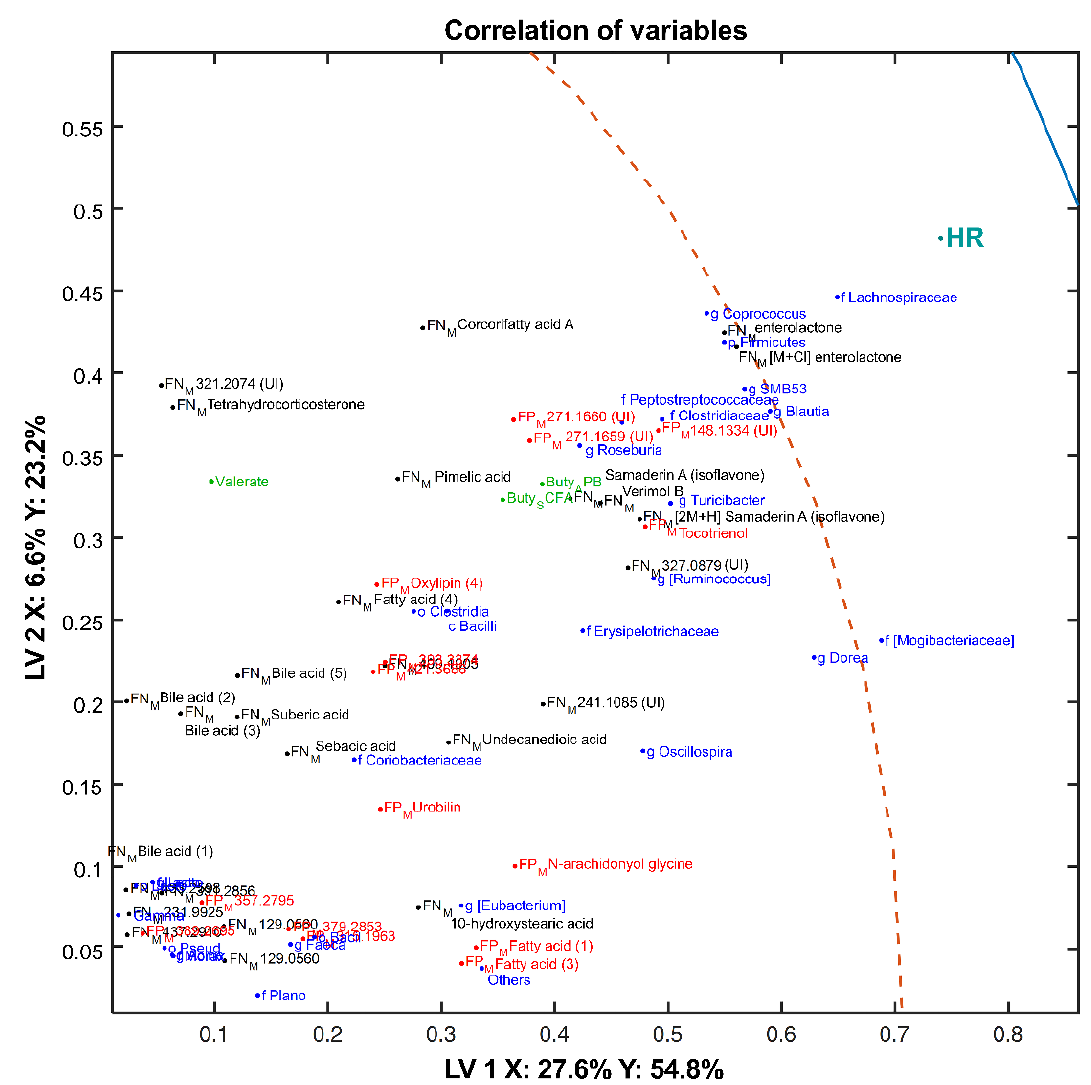
Figure 10. A detailed view of the correlation loading plot focusing on variables strongly associated with the HR diet (for a global overview of the correlation plot, we refer to Figure S5). Scores of a 4-block model: fecal ESI + metabolomics (FP M , red), fecal ESI − metabolomics (FN M , black), SCFAs (green), metataxonomics (blue) are used to plot the correlations. The first two components are shown with the explained variances in sample matrix X and the dietary treatment Y. Abbreviations: g, genus; f, family; o, order; k, kingdom; p, phylum; c, class; UI, unidentified compounds.